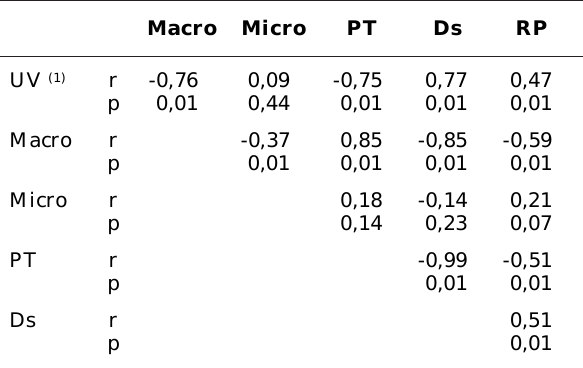
(1) UV = umidade volumétrica; Macro = macroporos; Micro = microporos; PT = porosidade total; Ds = densidade do solo e; RP = resistência à penetração.